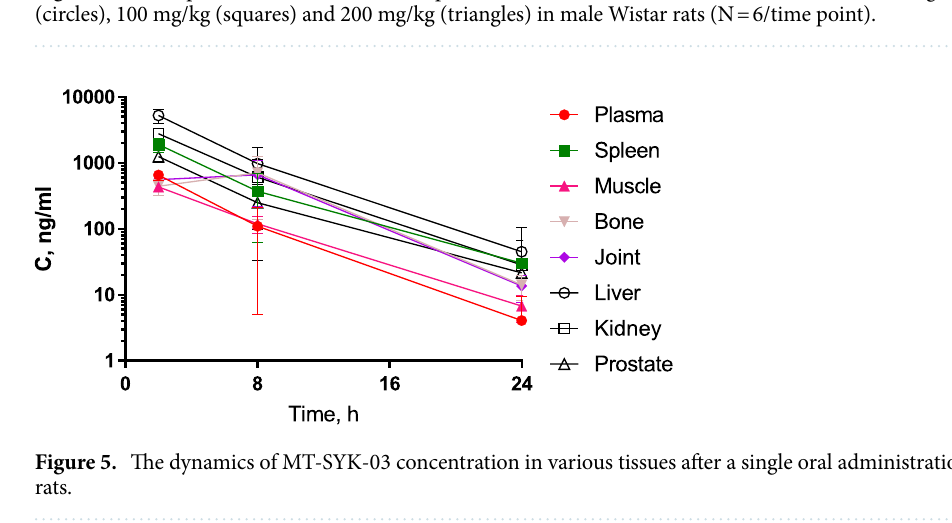
Figure 4. Mean plasma concentration–time profiles of MT-SYK-03 after PO administration of 30 mg/kg (circles), 100 mg/kg (squares) and 200 mg/kg (triangles) in male Wistar rats (N = 6/time point).